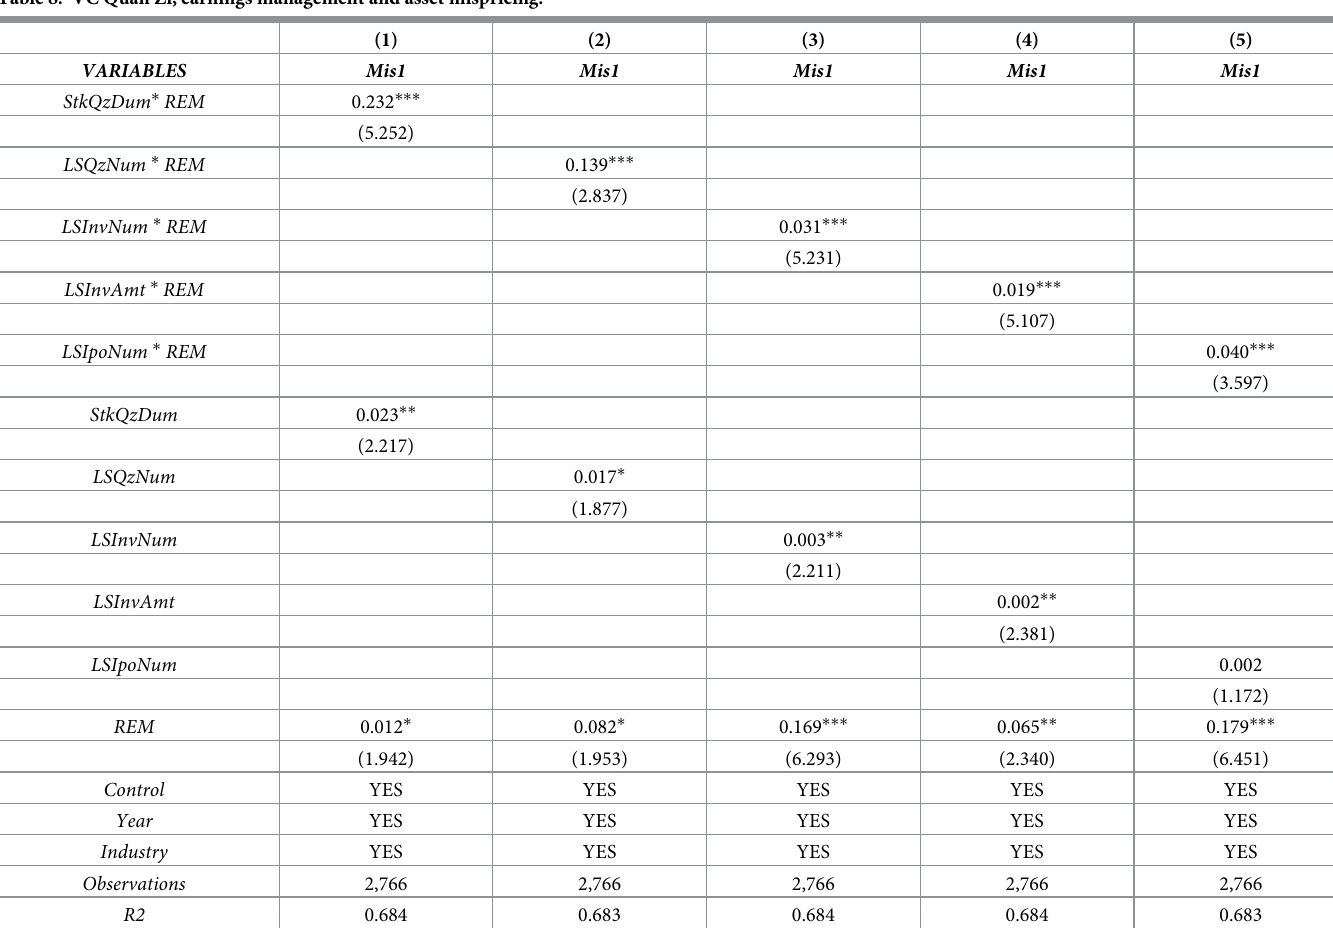
Table 8. VC Quan Zi, earnings management and asset